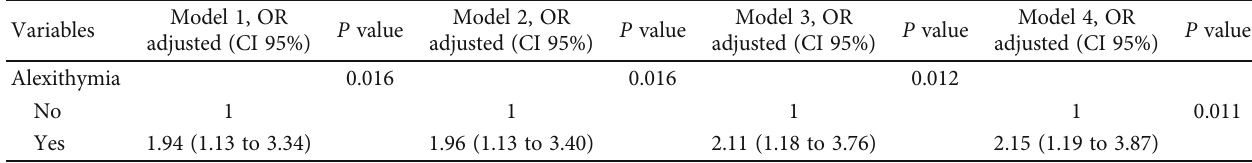
Table 4: Multivariate analyses ( n = 242 ).